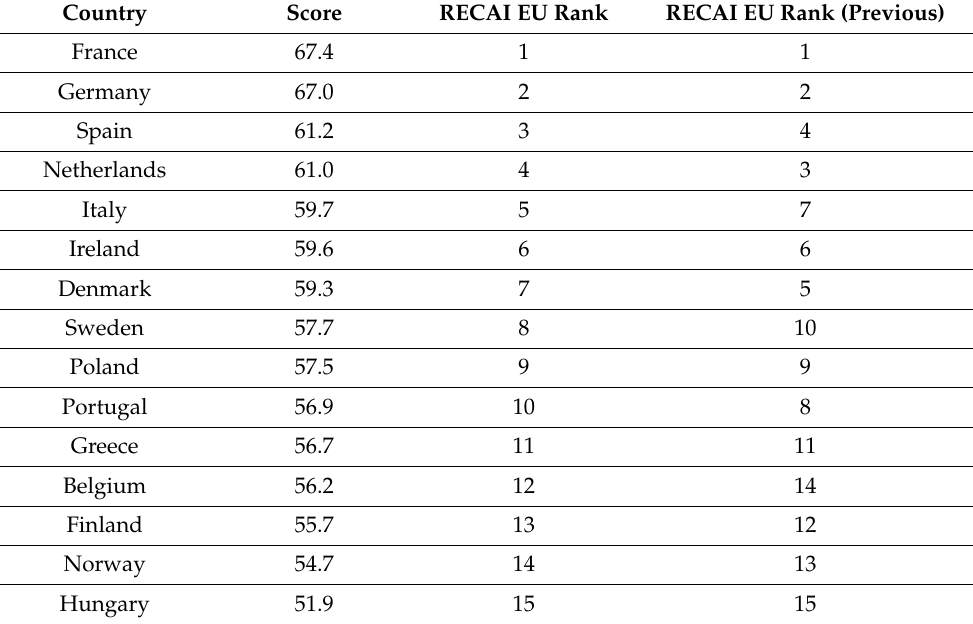
Table 1. EU country rankings in terms of RECAI scores.